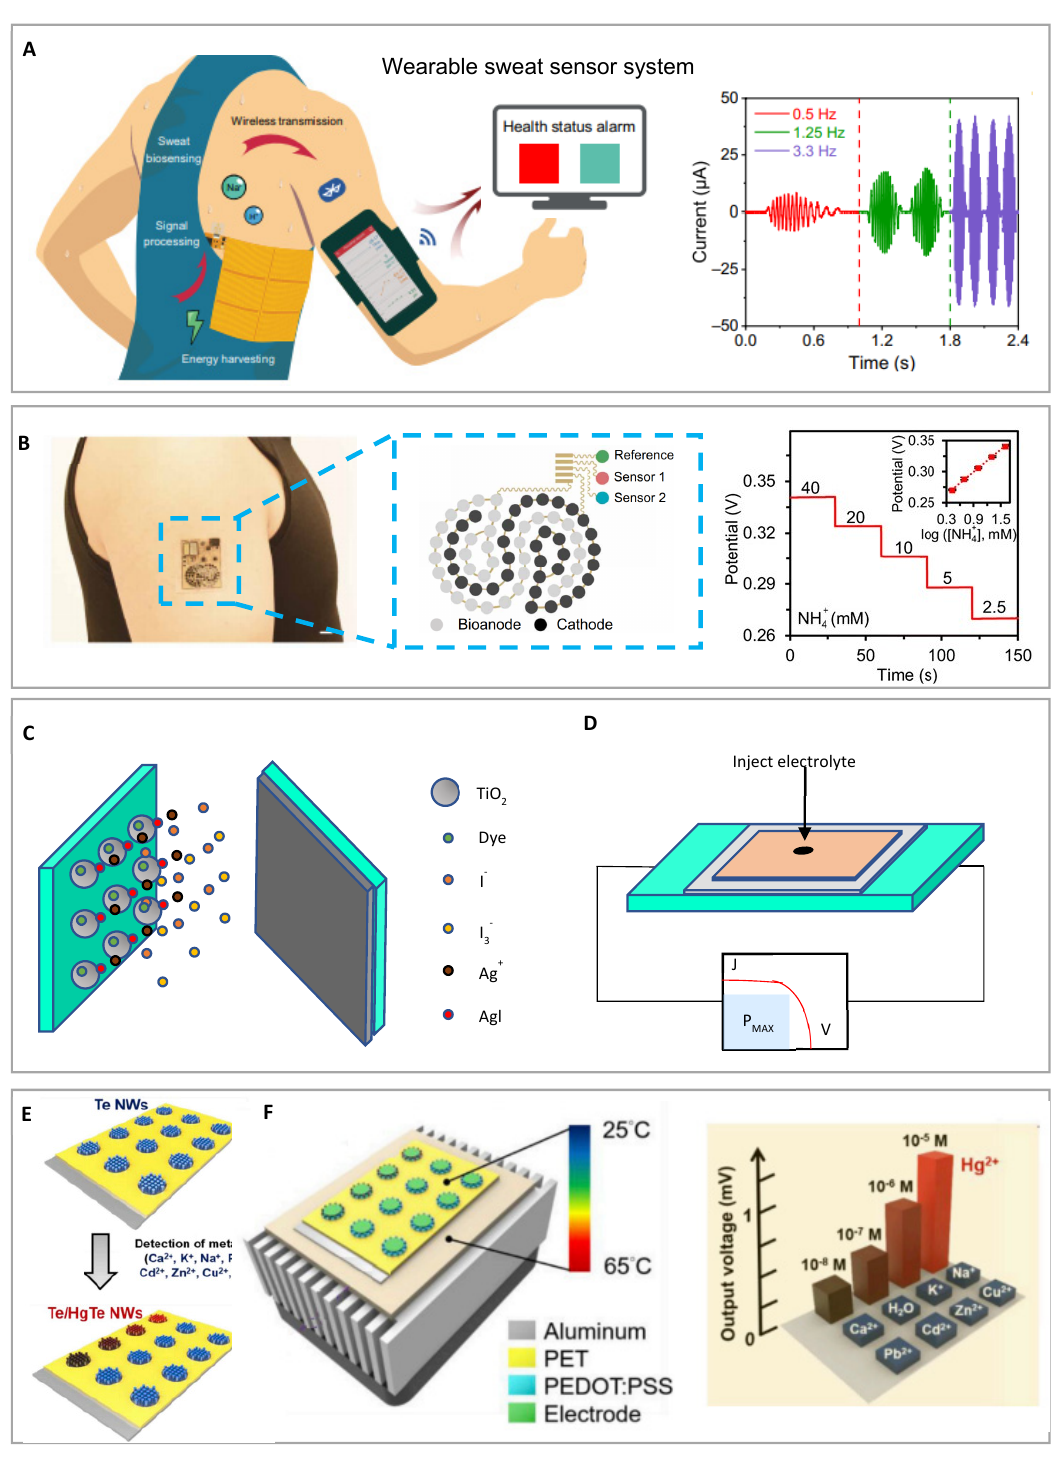
Figure 4. ( A ) From left to right shows integrated human motion energy harvesting a freestanding triboelectric nanogenerator (FTENG)-powered wearable sweat sensor system and the output energy. Reproduced with permission. Copyright 2020, American Association for the Advancement of Science [104]. ( B ) From left to right shows a biofuel-powered energy harvester and its output energy. The potentiometric responses of the NH 4+ sensors are measured in 40 to 2.5 mM NH 4+ solutions and they demonstrate near-Nernstian sensitivities of 60.3 mV per decade of concentration.